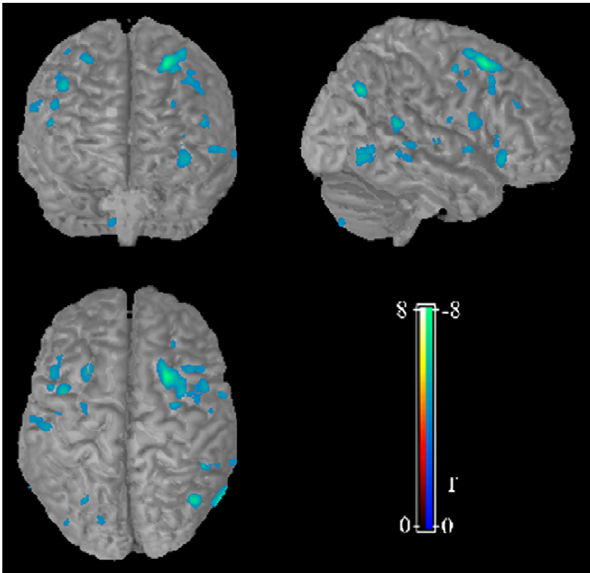
Figure 1. VBM analysis revealed decreased gray matter volume in MCI group compared to controls. Compared to the control group, the MCI group showed significantly decreased GMV (blue region) in mainly in bilateral prefrontal, left temporal and posterior cingulate cortex.